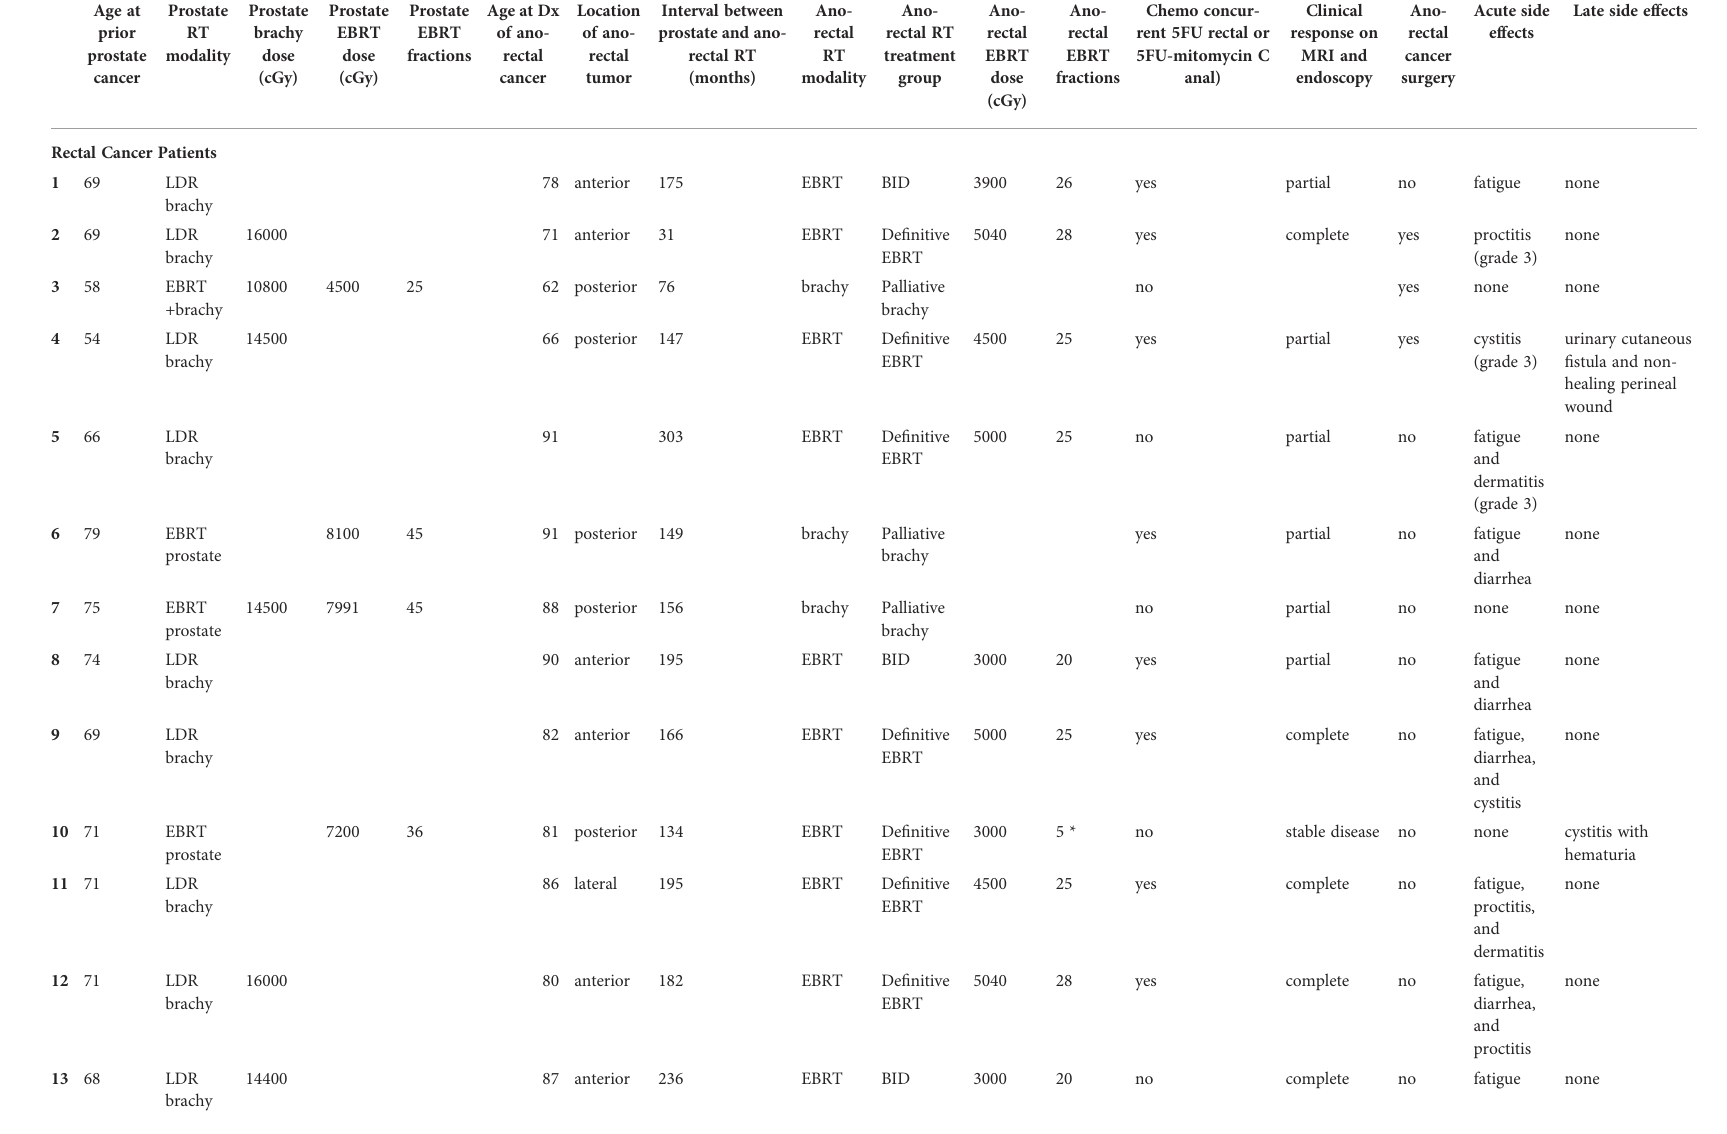
TABLE 1 Individual data on each of the twenty-six patients treated with radiation therapy for de novo rectal and anal cancers after prior prostate RT. Age at